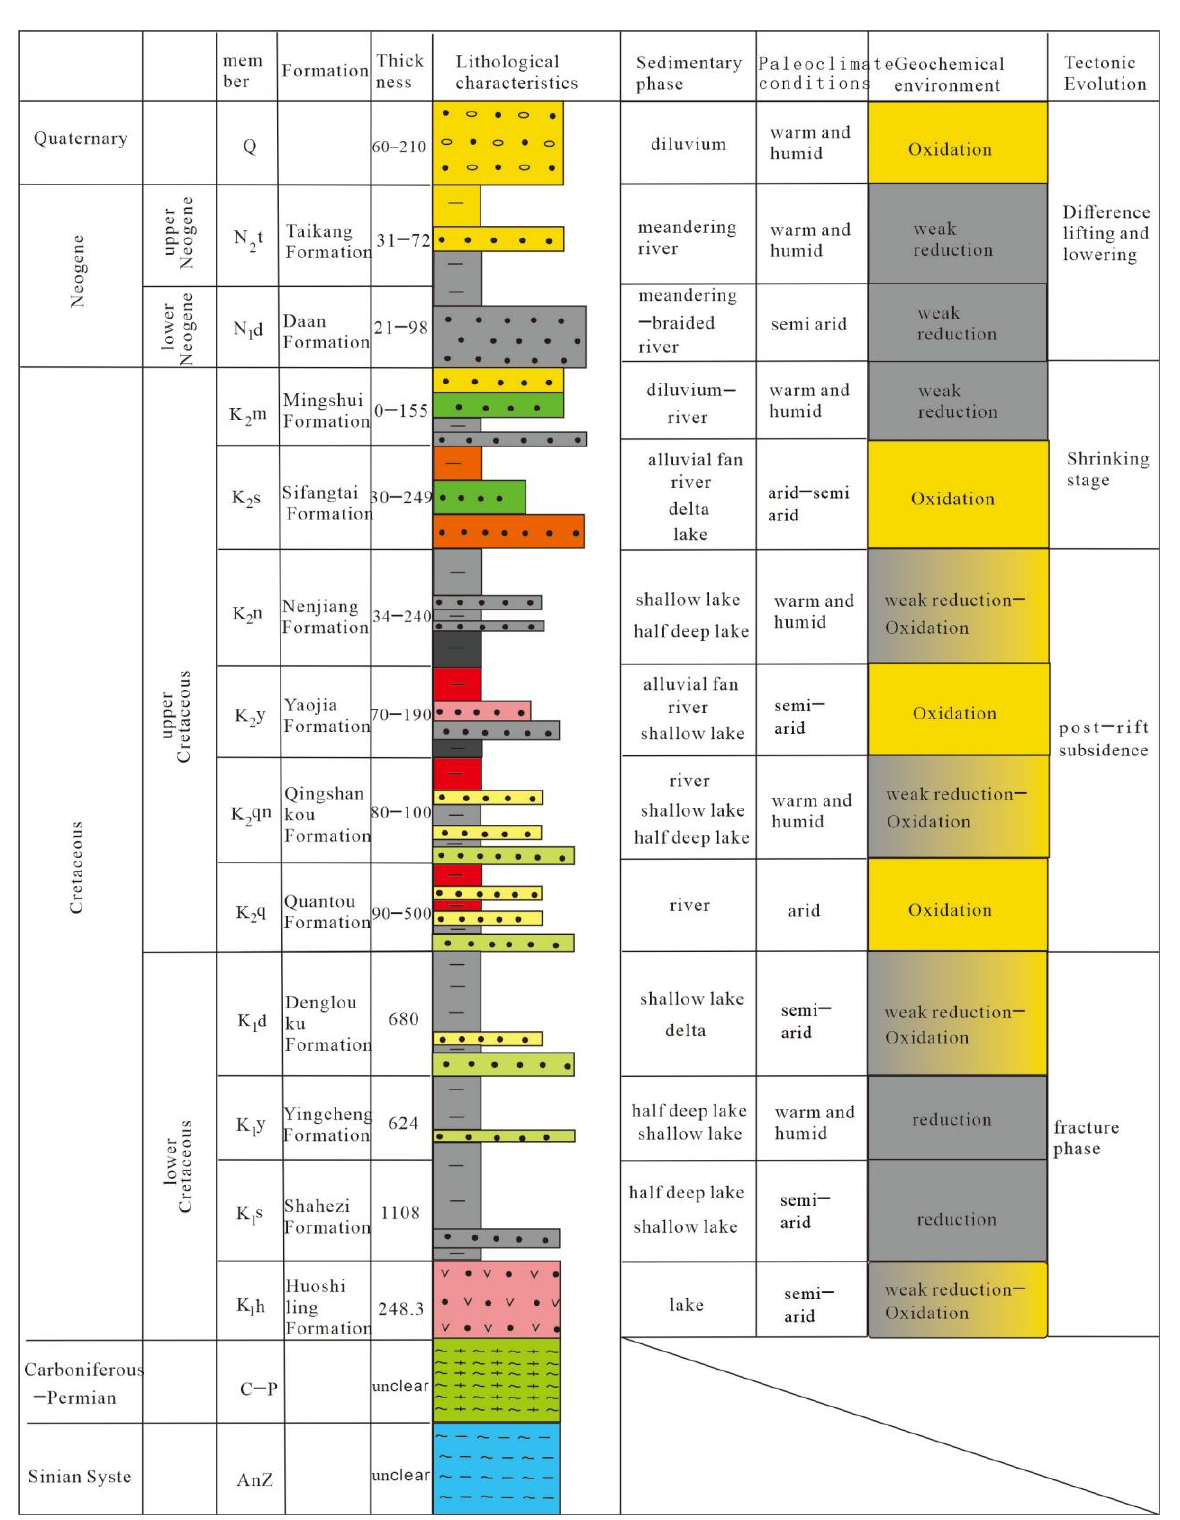
Figure 1. Sketch geological map of northeastern China (after [29,30]). GXR, Great Xing’an Range.